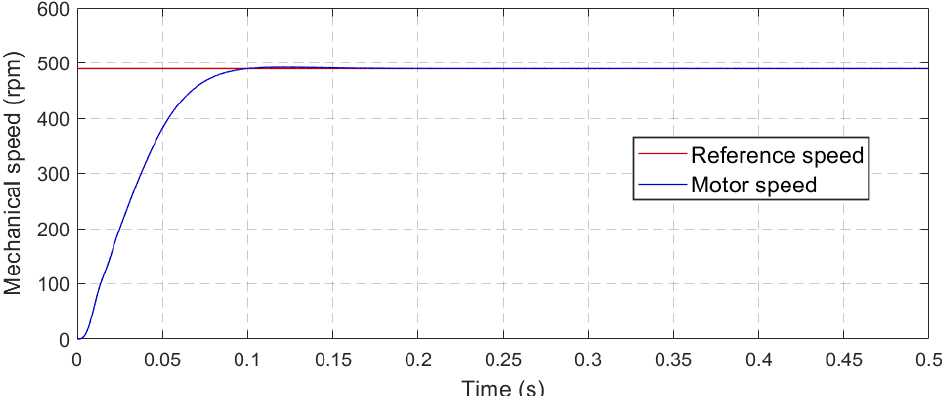
Figure 9. Reference speed and measured speed, (0, 0.5 s).